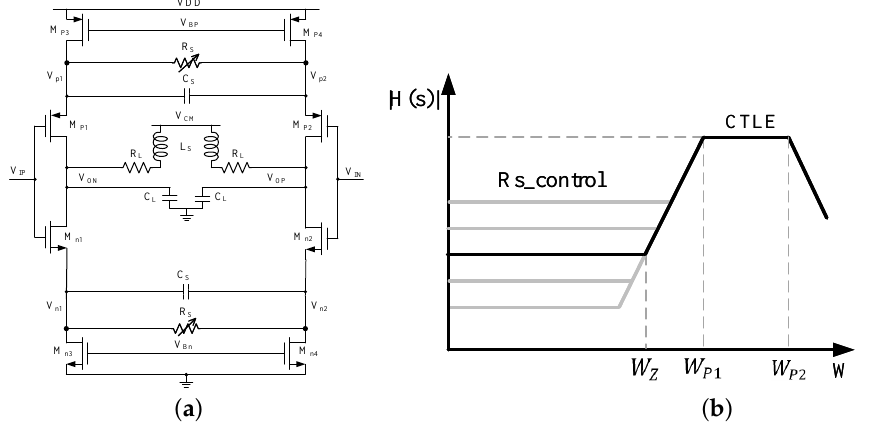
Figure 5. ( a ) CTLE structure, ( b ) its frequency